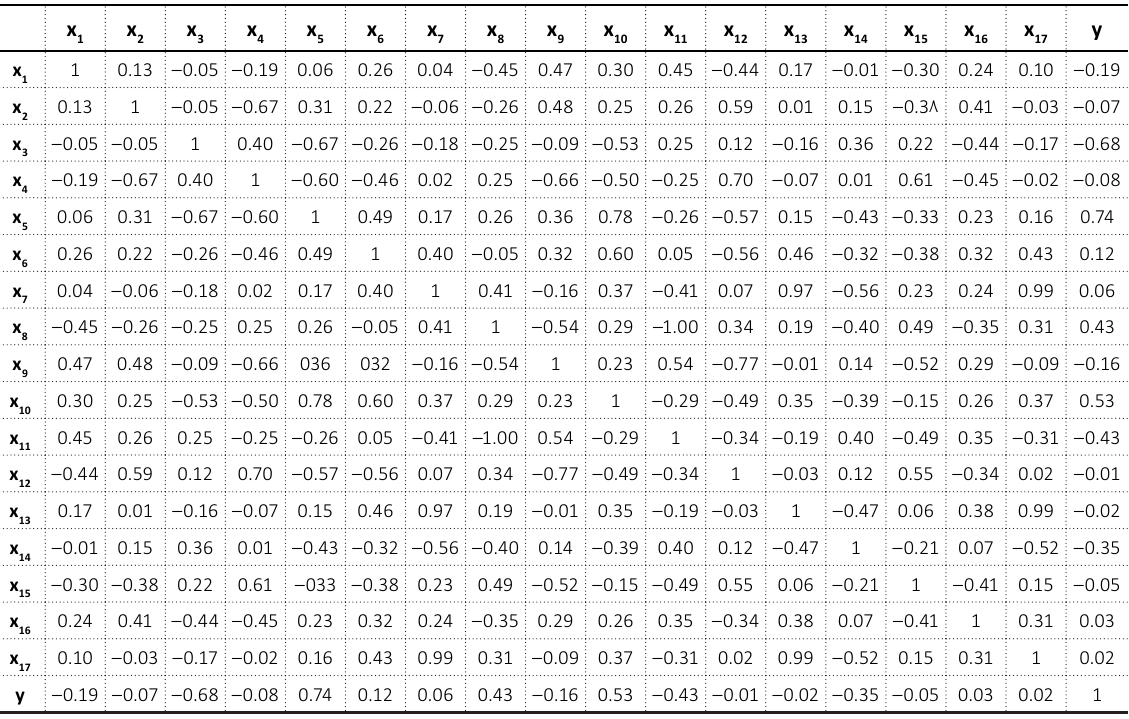
Table 4. Correlation matrix for 17 indicators